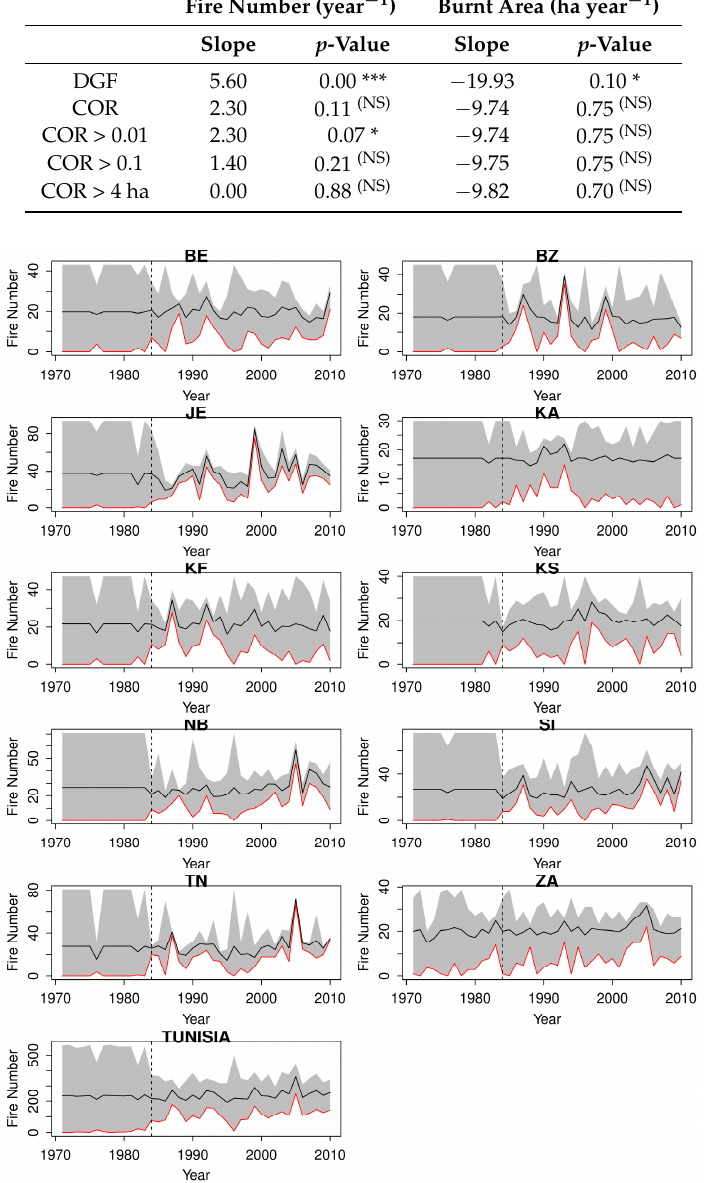
Figure 10. Yearly ( X -axis) fire numbers ( Y -axis) for each gouvernorat and Tunisia from 1971 to 2010 (vertical dashed line presenting year 1985 after which we consider the database to be reliable). The COR database (non-gap-filled, in red), gap-filled with mean (black line), and maximum (grey upper envelope boundary) fire numbers over the time series when a monthly report is missing.